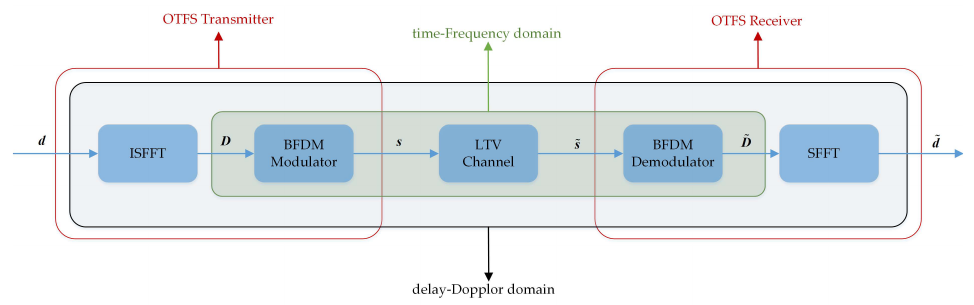
Figure 1. OTFS-BFDM system